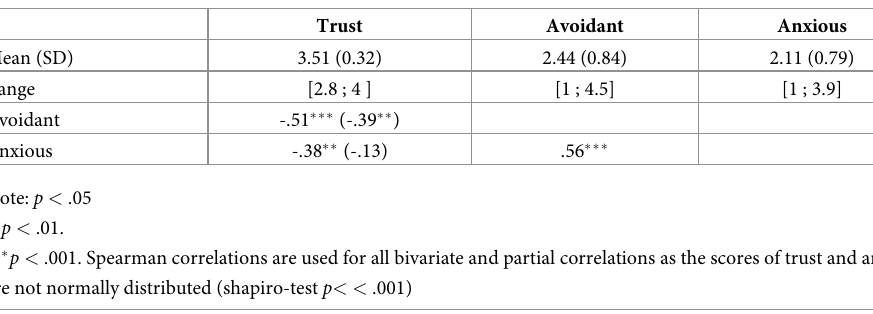
Table 2. Mean, standard deviation (SD), range, and (partial) spearman correlations of the self-reported attach- ment scores. Mean (SD) Range Avoidant